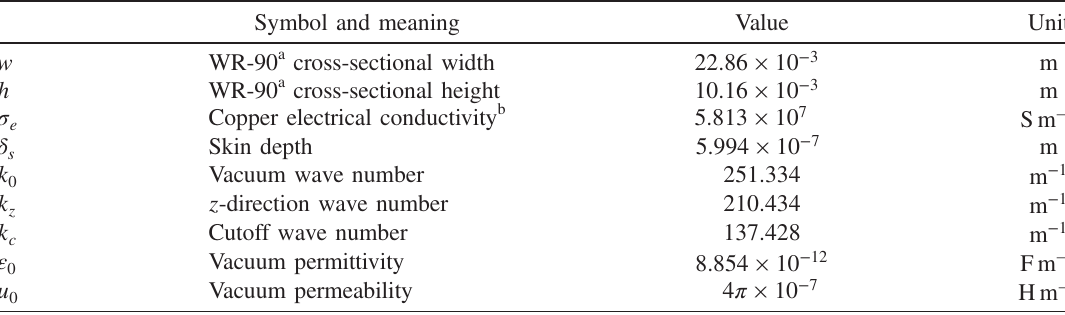
at f ¼ 11 . 9942 att